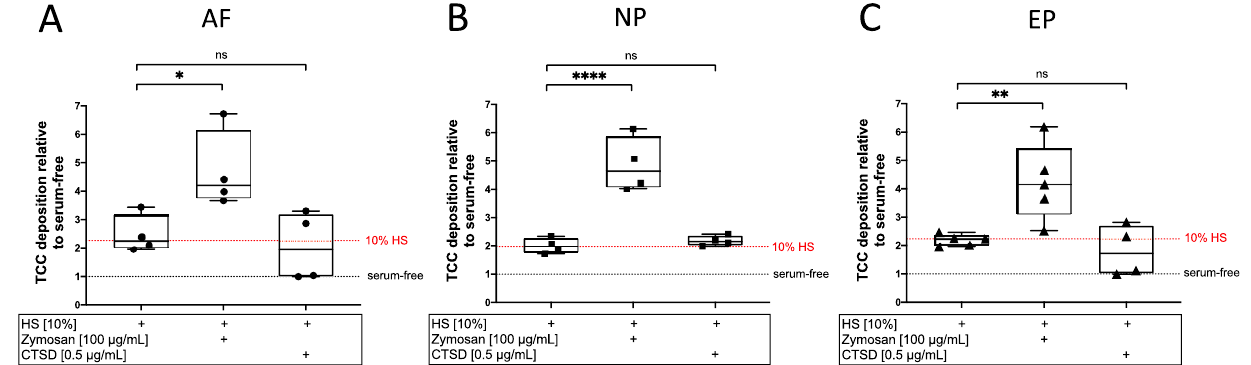
Figure 2. Evaluation of complement activation and subsequent TCC deposition induced by zymosan or cathepsin D (CTSD). Quantification of TCC deposition on isolated ( A ) annulus fibrosus (AF), ( B ) nucleus pulposus (NP), and ( C ) endplate (EP) cells stimulated with 10% human serum (HS) alone or with zymosan (100 µg/mL) or CTSD (0.5 µg/mL) for 2 h. Respective cells cultured in serum-free medium served as the control group. Sample values were normalized by the respective values of the serum-free control group (marked with black dotted line). Median TCC deposition after stimulation with 10% HS is indicated as a red dotted line. The results are presented as box-and-whisker plots with median ± interquartile ranges ( n = 4 – 5 donors per group). Significant differences are depicted as: * p < 0.05; ** p < 0.01; **** p < 0.0001; ns: not significant. One-way ANOVA was used.